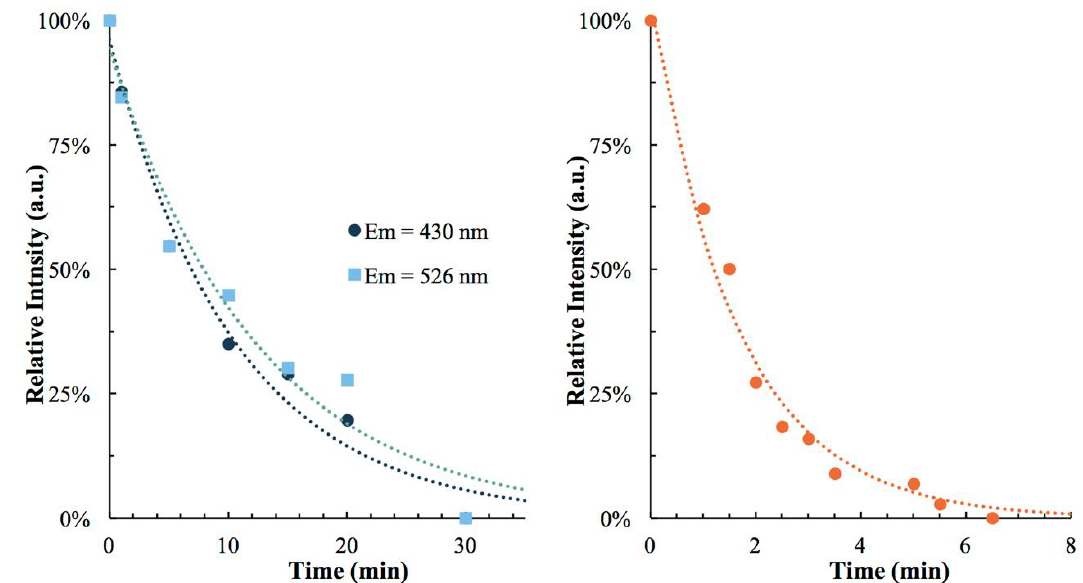
Figure 8. Relative emission loss over time for 1 ( left ) and 2 ( right ) at 78 K under 255 nm laser irradiation. Note that the emission signal of 1 is deconstructed to show the independent intensities of the dominant emission peak at 430 nm and the less intense emission peak at 526 nm.